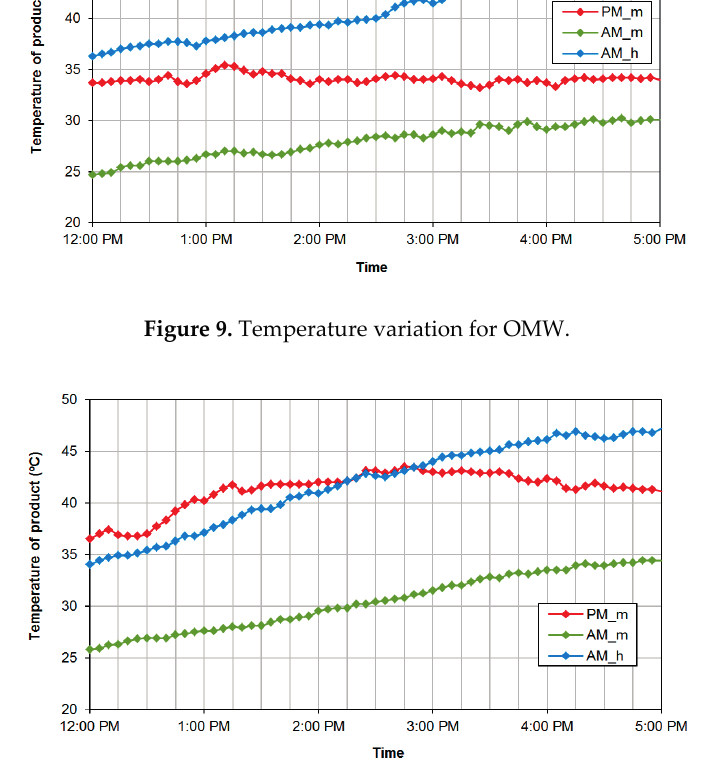
Figure 10. Temperature variation for SLG.